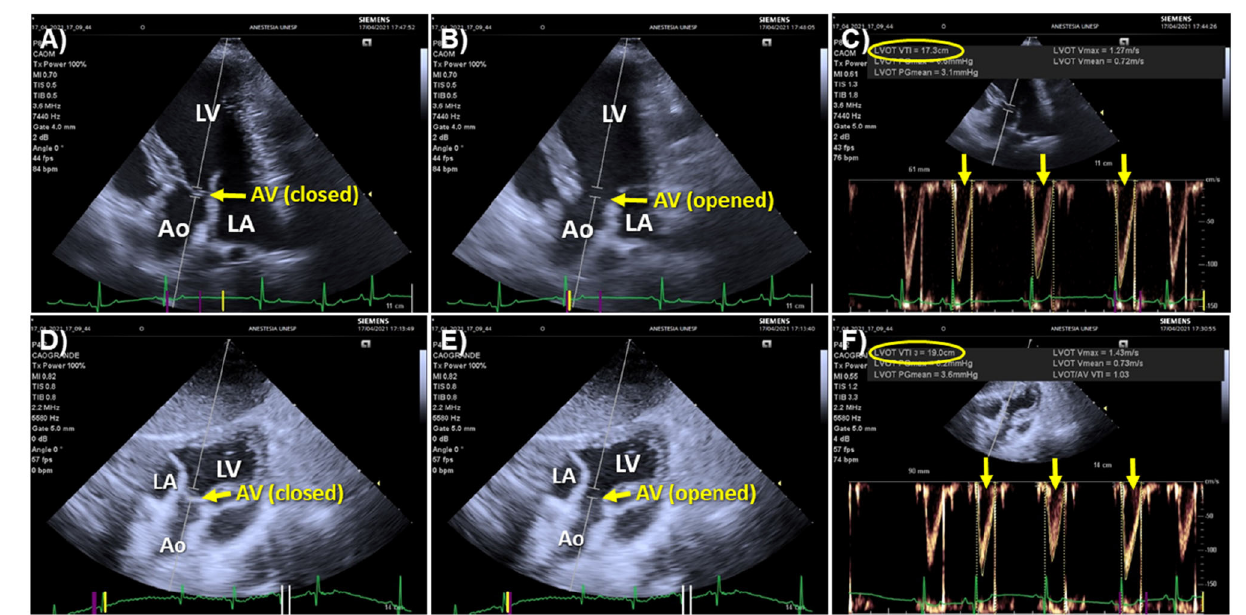
FIGURE 3 | Echocardiographic windows used to measure aortic flow velocity-time integral (VTI) in dogs. (A) Left parasternal, apical five-chamber view optimized for visualizing the left ventricular outflow tract (LVOT) with the aortic valve closed during diastole. The Doppler beam is aligned as parallel as possible with the aortic outflow and the Doppler sampler is positioned just below the mitral annulus (point of insertion of aortic valve leaflets). (B) The same image with the aortic valve (AV) opened during systole. (C) Acceleration of aortic flow over time measured by positioning the Doppler cursor as shown in (A,B) . The aortic flow VTI averaged of 3 sequential heartbeats (yellow arrows) using an automated algorithm was 17.3cm (yellow oval). (D) Subxiphoid view of the LVOT showing alignment of the Doppler beam with the aortic outflow and the placement of the Doppler sampler with the AV closed during diastole. (E) The same image with the AV opened during systole. (F) Measurement of aortic flow VTI according to the subxiphoid view. The VTI averaged from 3 sequential heartbeats (yellow arrows) was 19.0cm (yellow oval). Comparison between the five-chamber (A,B) and subxiphoid views (D,E) shows that the latter allowed better alignment of the Doppler beam with the aortic outflow, which contributed to a higher VTI measured from the subxiphoid view. Ao, aorta; AV, aortic valve; LV, left ventricle; LA, left atrium.